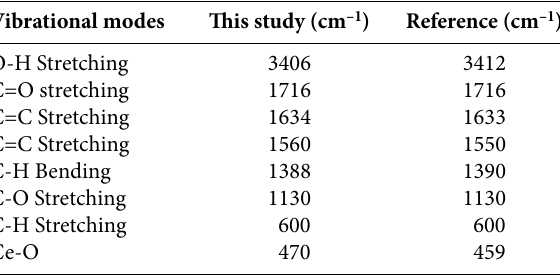
Table 2. Vibrational frequencies IR spectroscopy of various MO/AC.